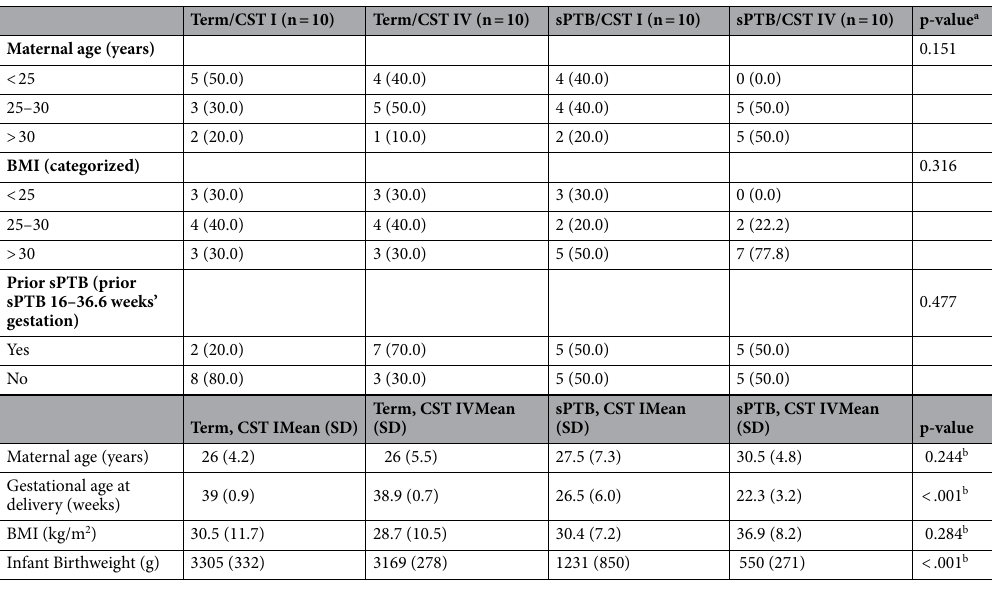
Table 1. Demographic characteristics by Community State Type and birth outcome (n = 40). Table presented as n (col %). a Fisher’s exact p-value unless otherwise indicated. b 2-way ANOVA